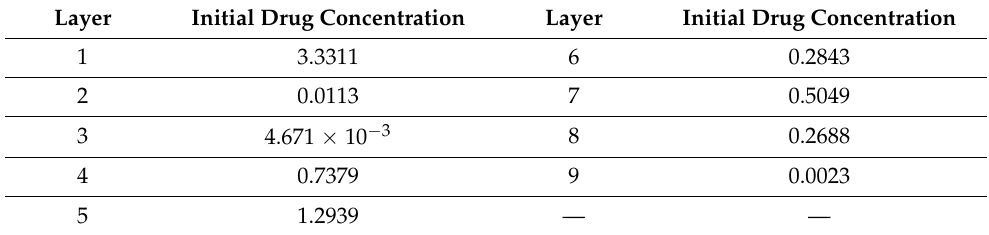
Figure 5. Drug Release profiles for different layers NL = 8, 9, 10. (Case 2). Table 4. Initial drug concentration at each layer of the drug-controlled release system with NL = 9 (Case 2).